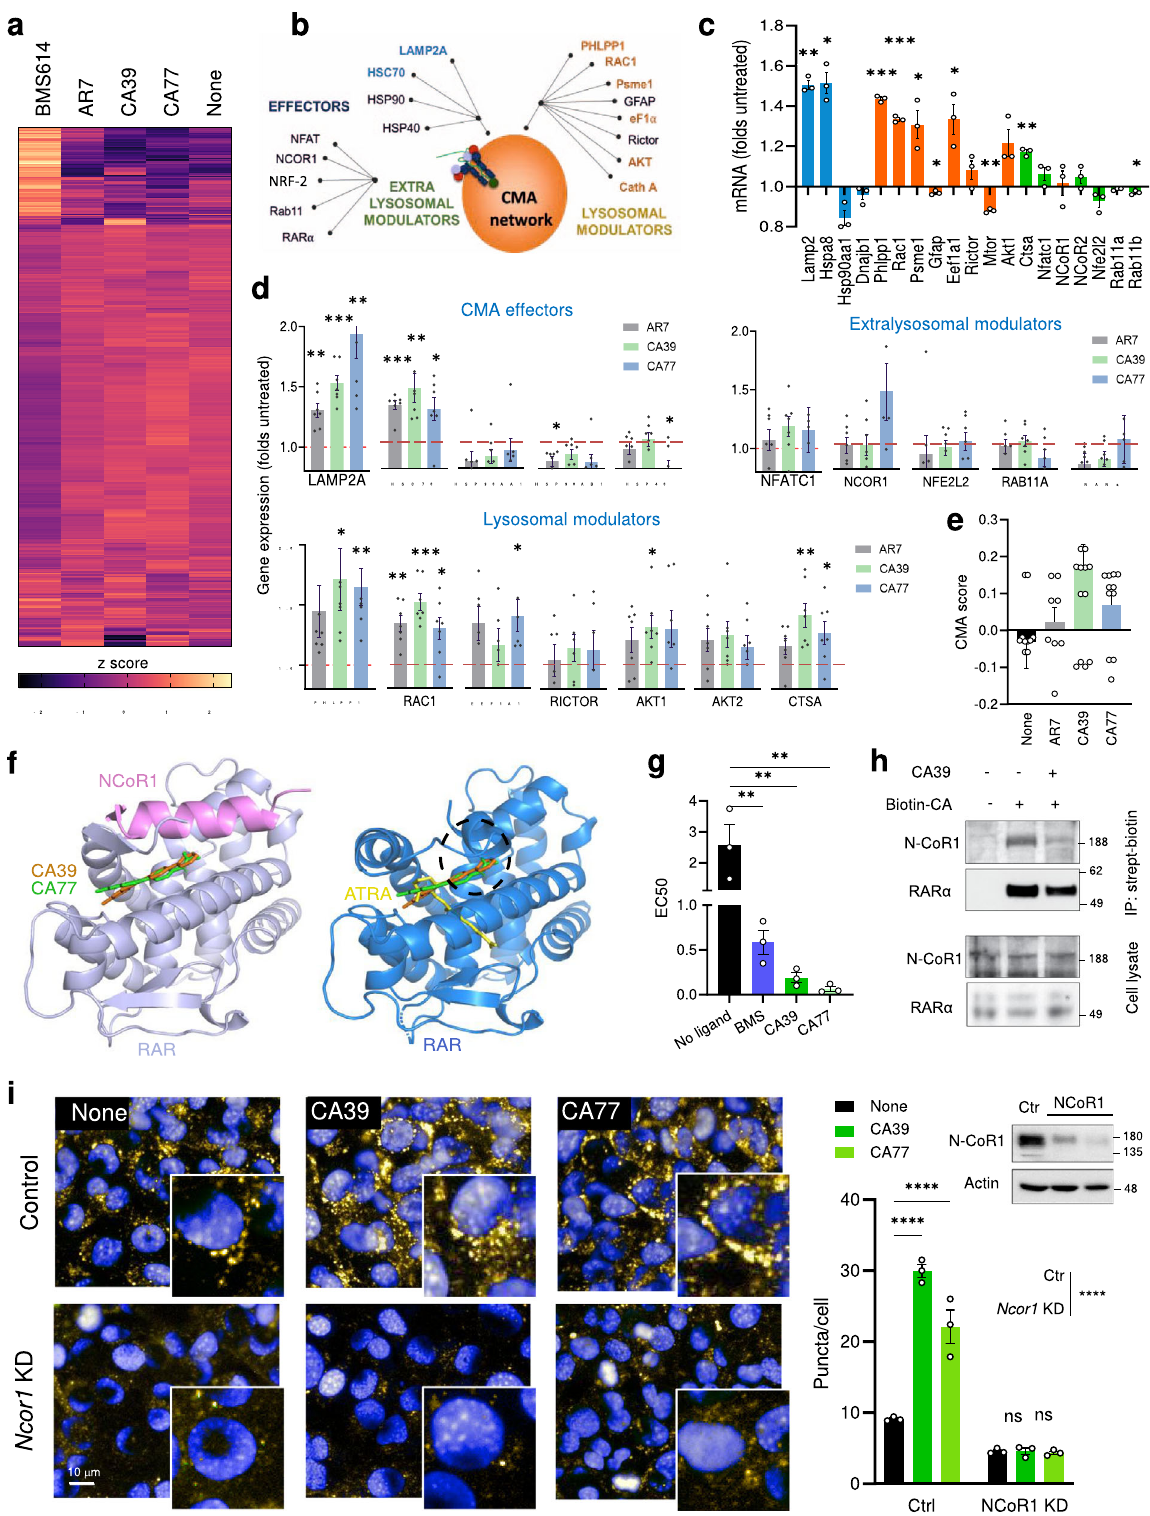
the predicted brain concentration of CA77 is in the range of 5- 20 μ M and of CA39 is 10 – 20 μ M when considering its AUC and extended half-life. Image analysis of tissues from KFERQ-Dendra mice adminis- tered these concentrations daily for 3 days, revealed that both CA39 and CA77 activate CMA with comparable potency in vivo both in peripheral blood cells and in multiple organs.